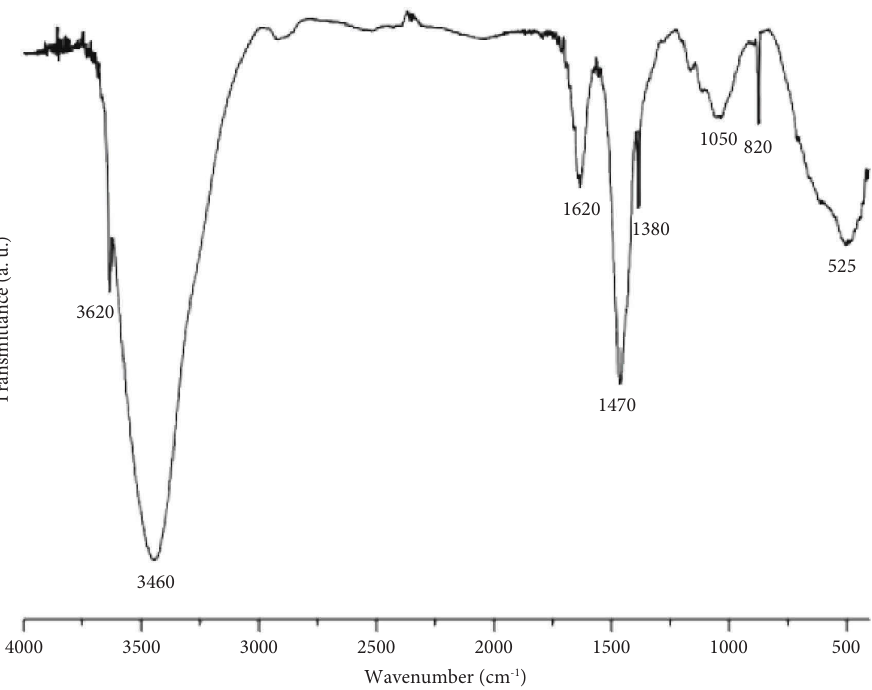
Figure 6: IR spectrum of the cobalt hydroxide deposited sample [2].